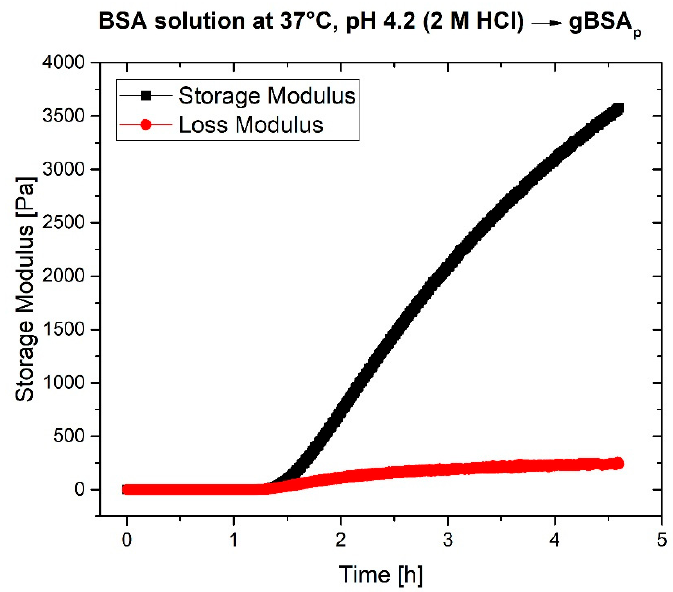
Figure A1. 3 mM BSA solution with no EtOH at 37 °C on rheometer plate. The pH is set to 4.2 by using 2M HCl.